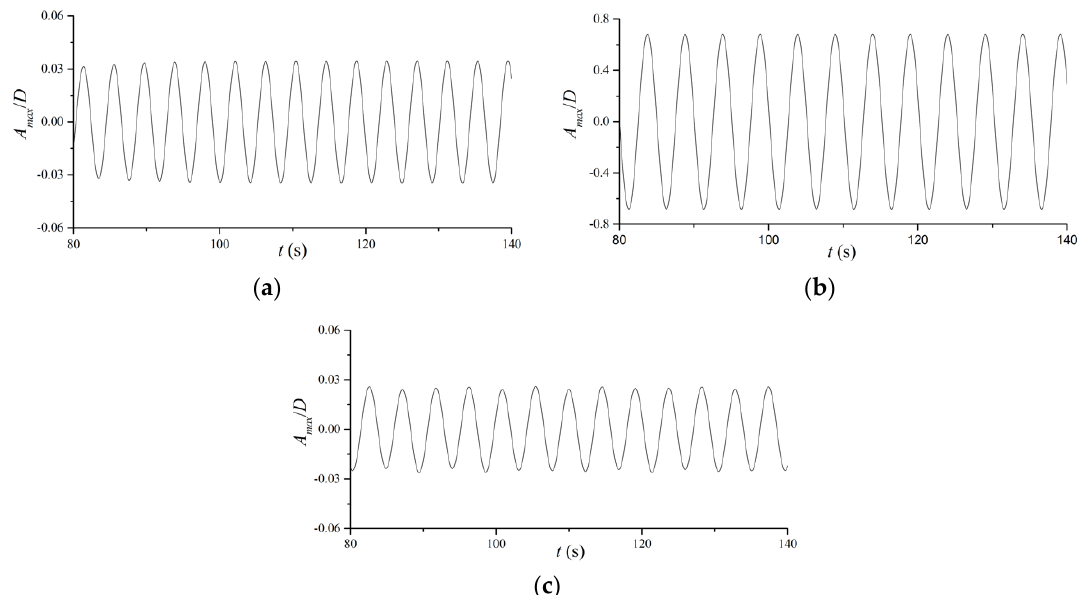
Figure 6. Time histories of submerged floating tunnel (SFT) motion under different reduced velocity: